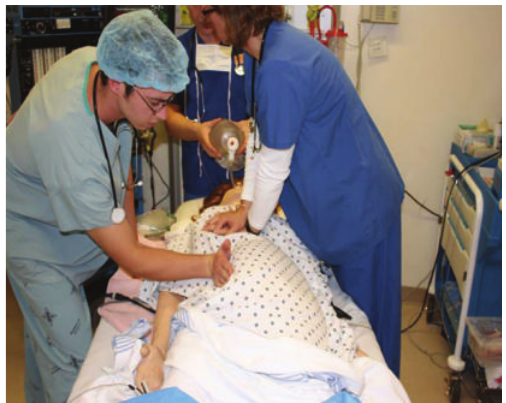
Figure 4: Manual leftward uterine displacement-with resuscitation team